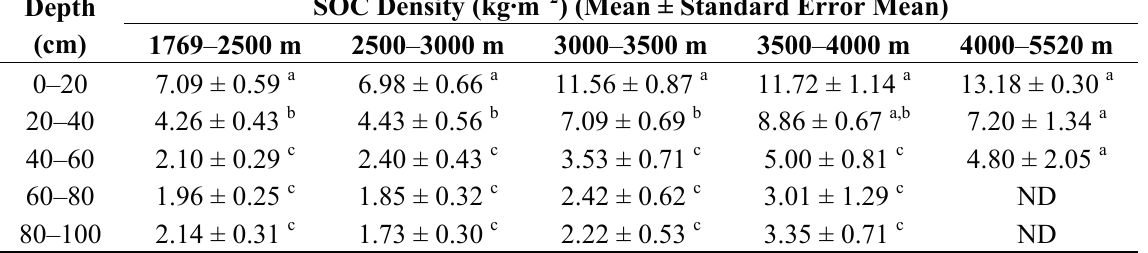
Table 6. Vertical distribution of mean SOC density values under different altitudinal zones. SOC Density (kg·m − 2 ) (Mean ± Standard Error Mean) Depth (cm) 1769 – 2500 m 2500 – 3000 m 3000 – 3500 m 3500 – 4000 m 4000 – 5520 m 0–20 7.09 ± 0.59 a